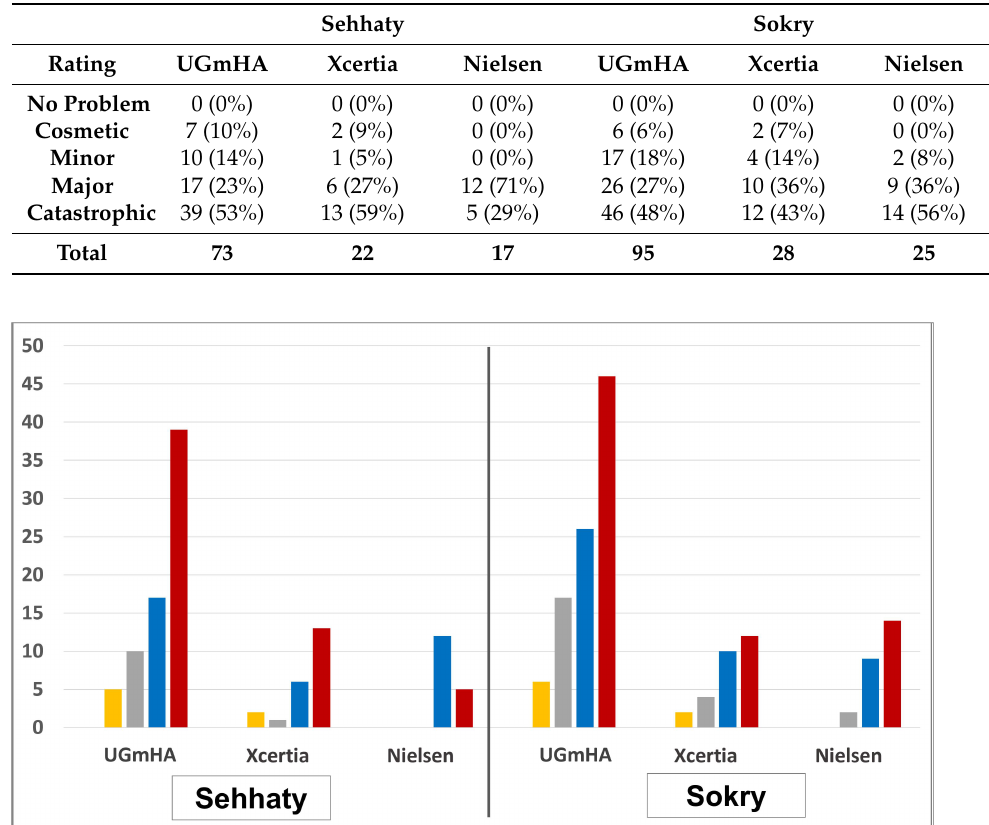
Table 12. Severity of usability issues of the “Sehhaty” and “Sokry” applications.